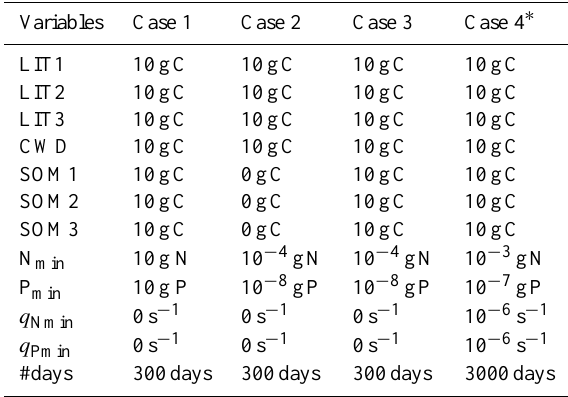
Table 3. Initial conditions and integration length (#days) for the analyzed model